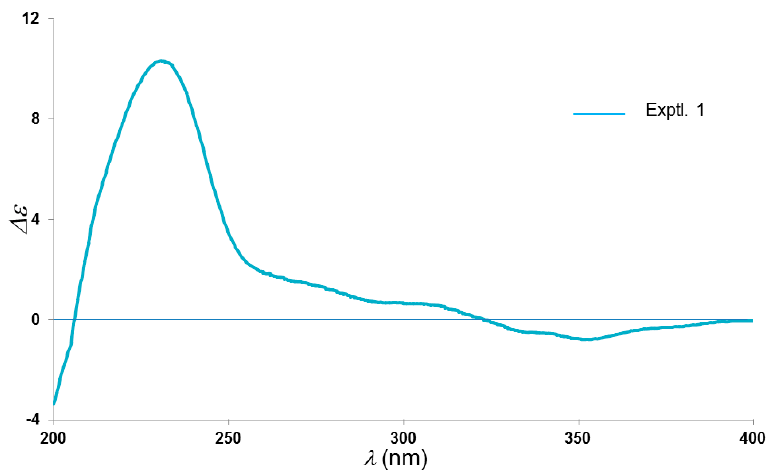
Figure 3. Experimental ECD spectrum of 1 (in CH 3 OH).